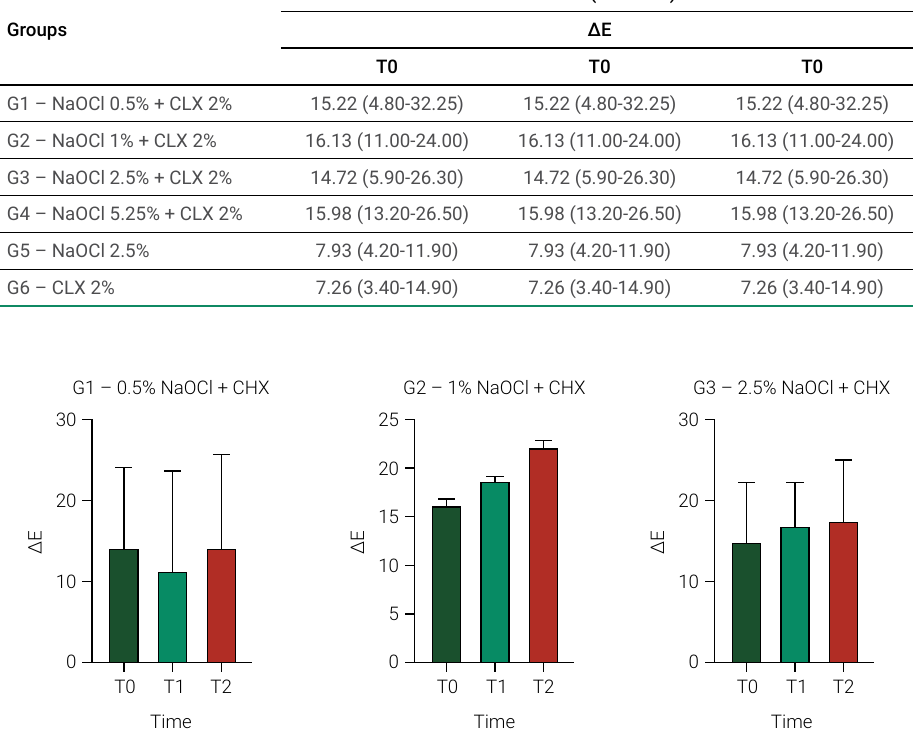
Median (min-max) ΔE